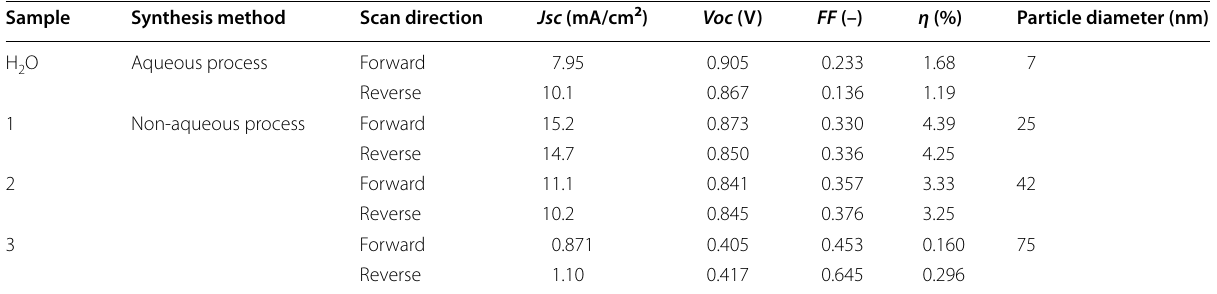
Table 1 Performance of perovskite solar cell using synthesized ZnO nanoparticles